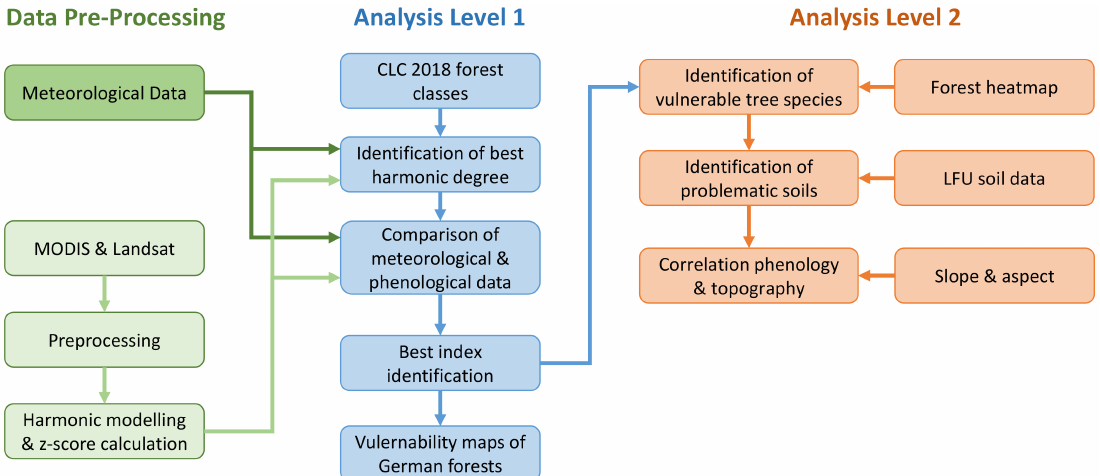
Figure 1. Flowchart of the study outline. The analysis was conducted on two levels. The first level was designed to identify optimal predictor combinations for drought assessment on a national scale. The second level was dedicated to study local drought response of different tree types depending on present soil types and topographic